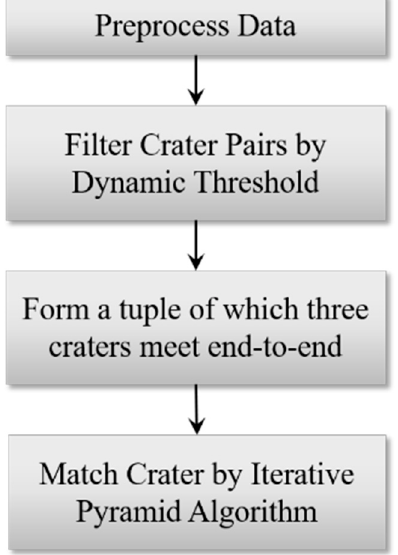
Figure 3. Flowchart of the LIS recognition algorithm.